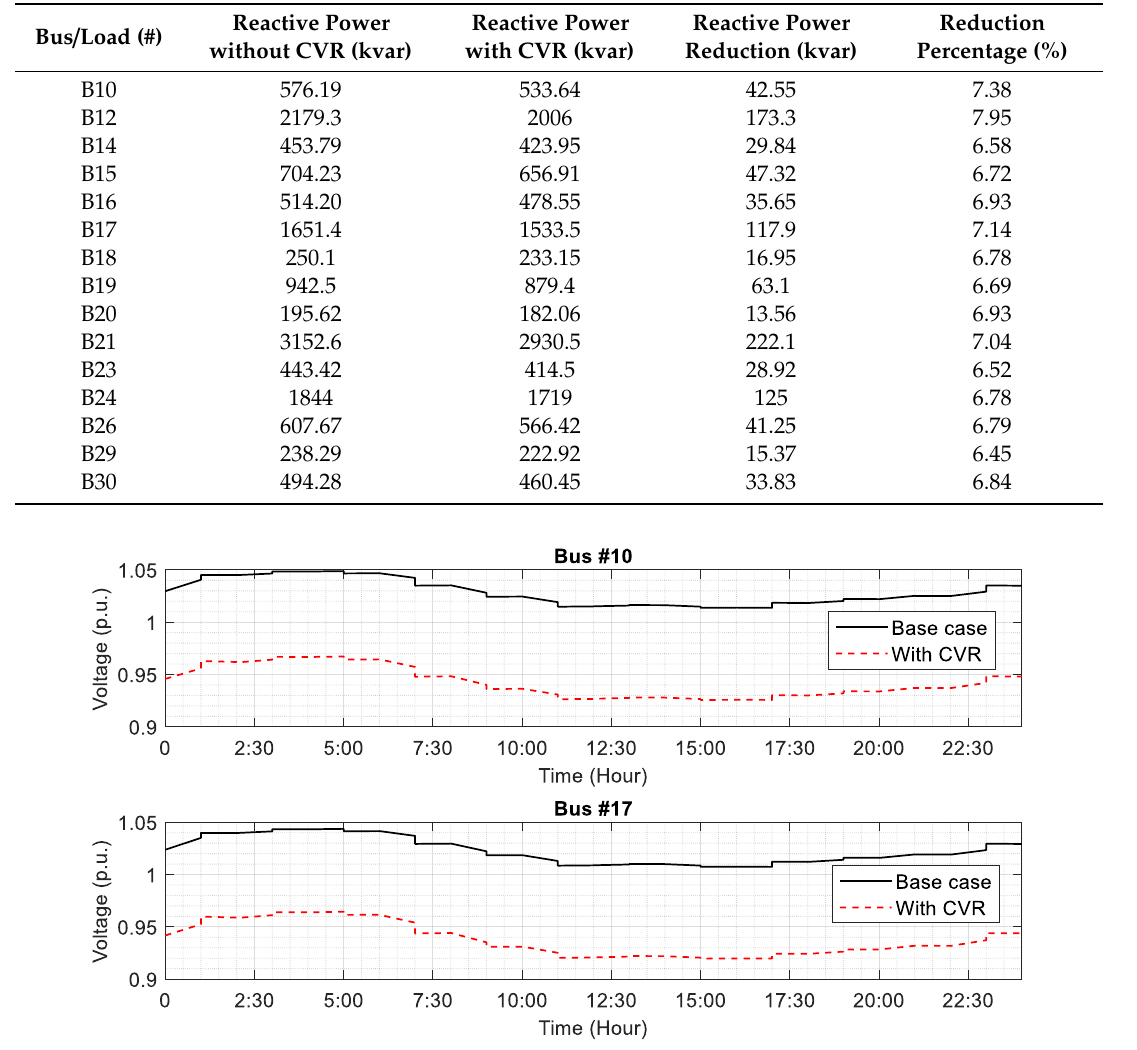
Table 3. Case III: Reactive power with / without CVR.